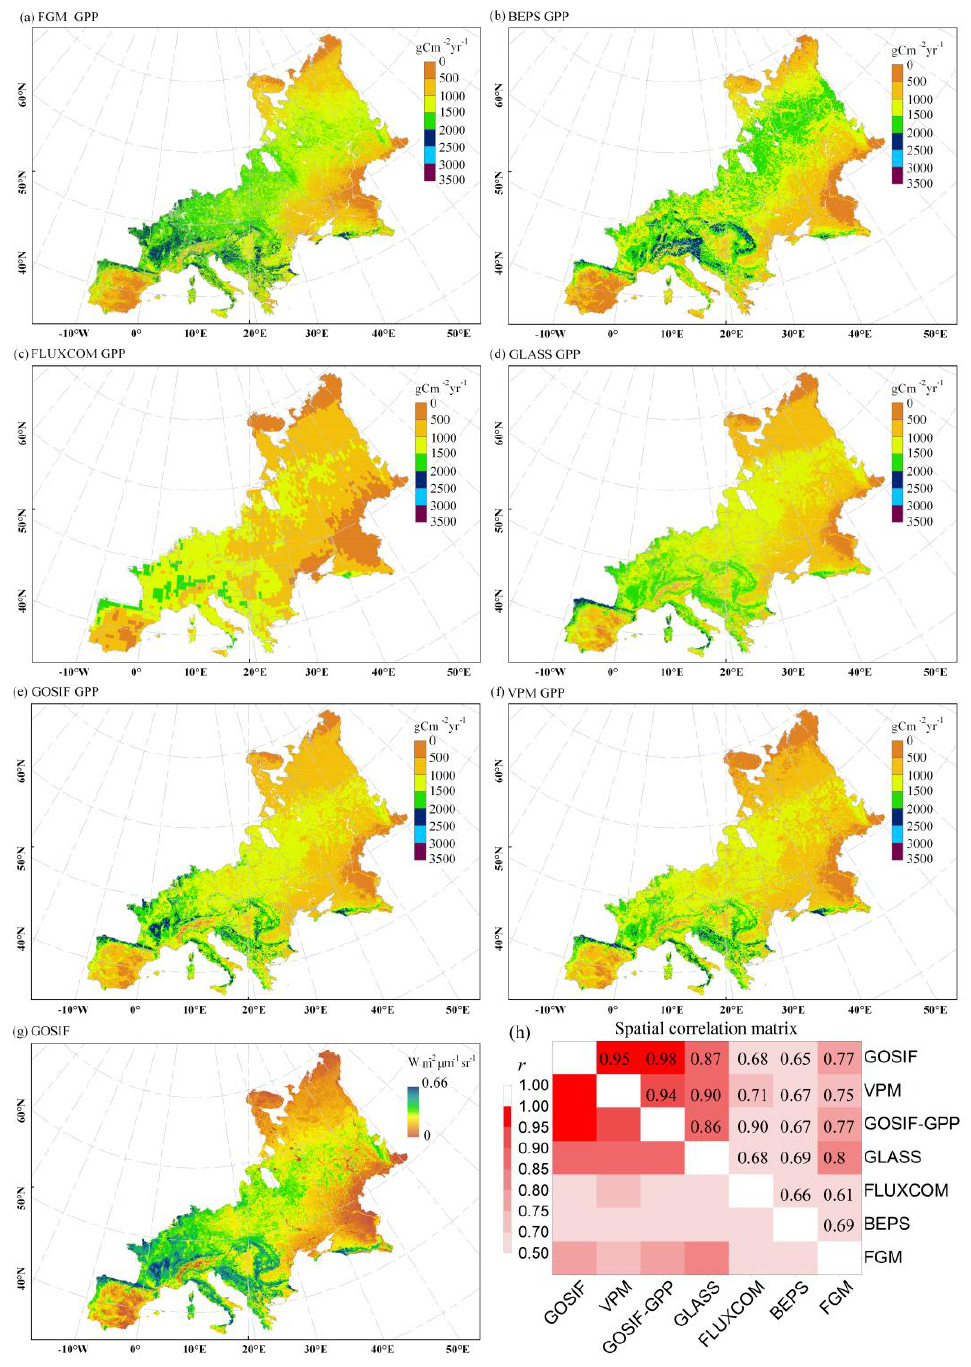
Figure 5. Spatial distribution of mean annual European GPP and SIF based on different sources of data, including ( a ) FGM GPP, ( b ) BEPS GPP, ( c ) FLUXCOM GPP, ( d ) GLASS GPP, ( e ) GPP derived from GOSIF, ( f ) VPM GPP, and ( g ) original GOSIF data. Here, ( h ) illustrates the correlation matrix between these data.